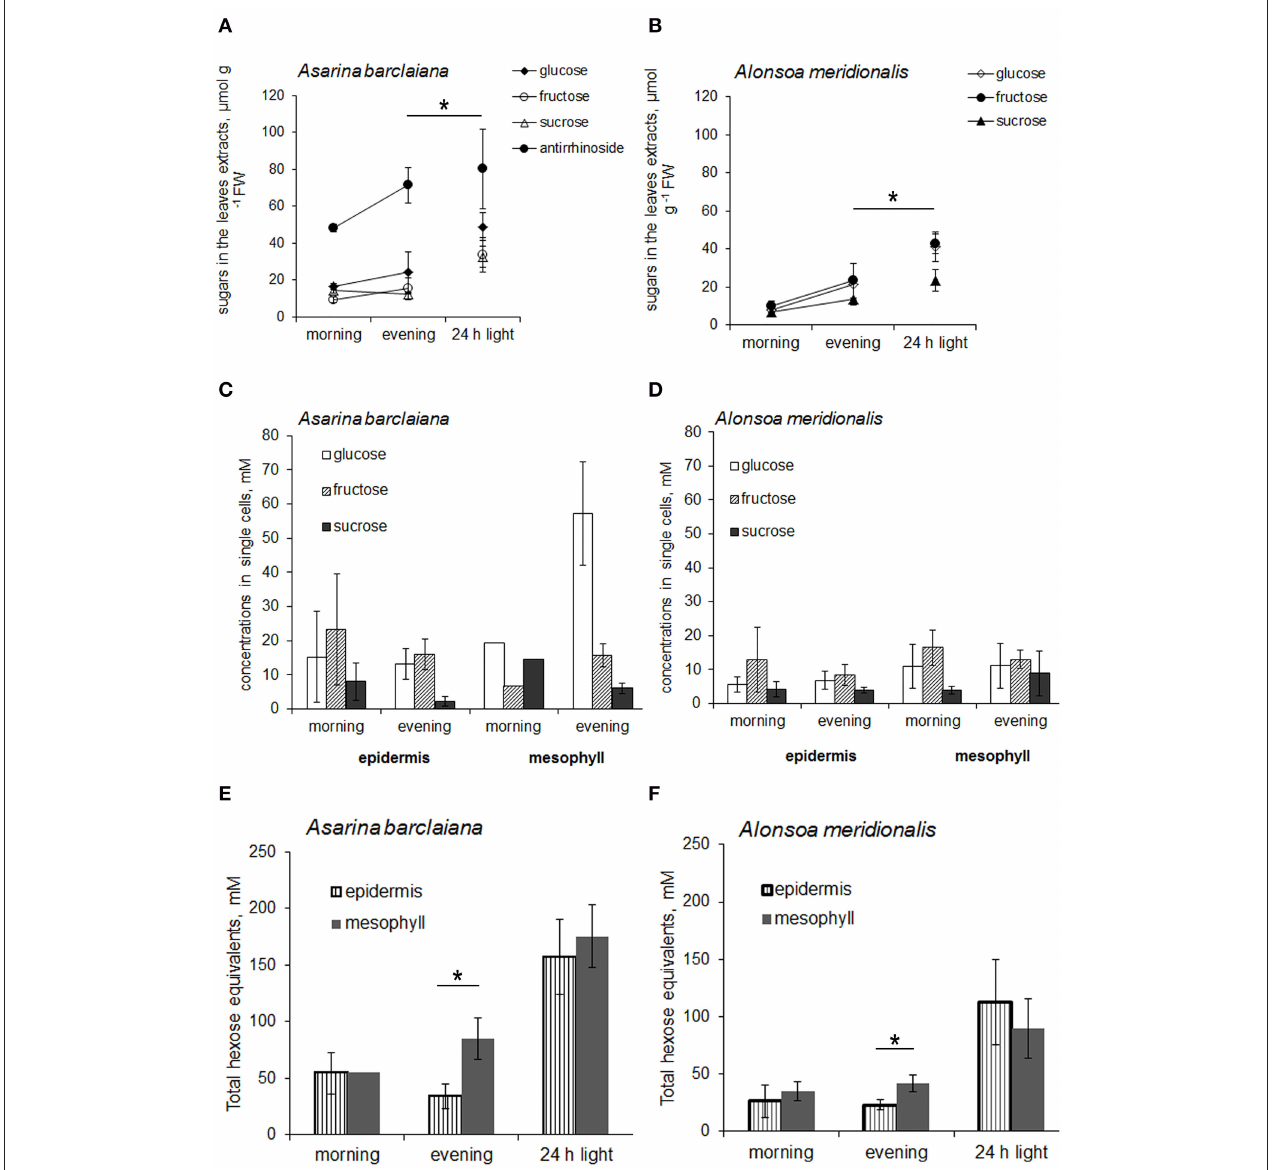
FIGURE 5 | Sugar concentrations in leaves (A,B) and in single cells samples obtained from the epidermis and mesophyll (C–F) of A. barclaiana (A,C,E) and A. meridionalis (B,D,F) at the beginning of the light period after 3h of illumination (“morning”), at the end of the light period after 11h illumination (“evening”), and after 24h exposure of detached leaves to continuous light, respectively. (A,B) Open triangles stand for glucose, closed triangles for fructose, open circles for sucrose, and closed circles for antirrhinoside, respectively. Mean values of 3–5 independent measurements ± SE are shown except for the “morning” time points in (C) and (E) which represent the values from a single measurement. Data in (E) and (F) are expressed on the basis of hexose equivalents for total amounts of glucose, fructose, and sucrose. Asterisks indicate significant different values at least at the p < 0.05 level according to Student’s t -test, except for antirrhinoside contents (A) where differences between “evening” and “24h light” points were